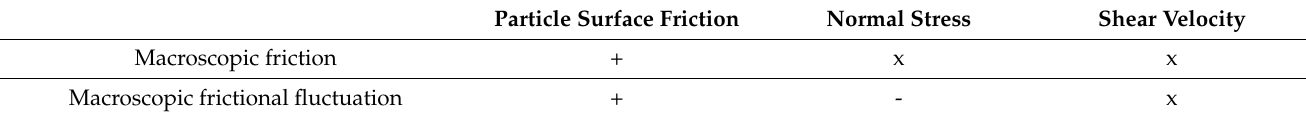
Table 2. Conclusions in the spherical particle system.